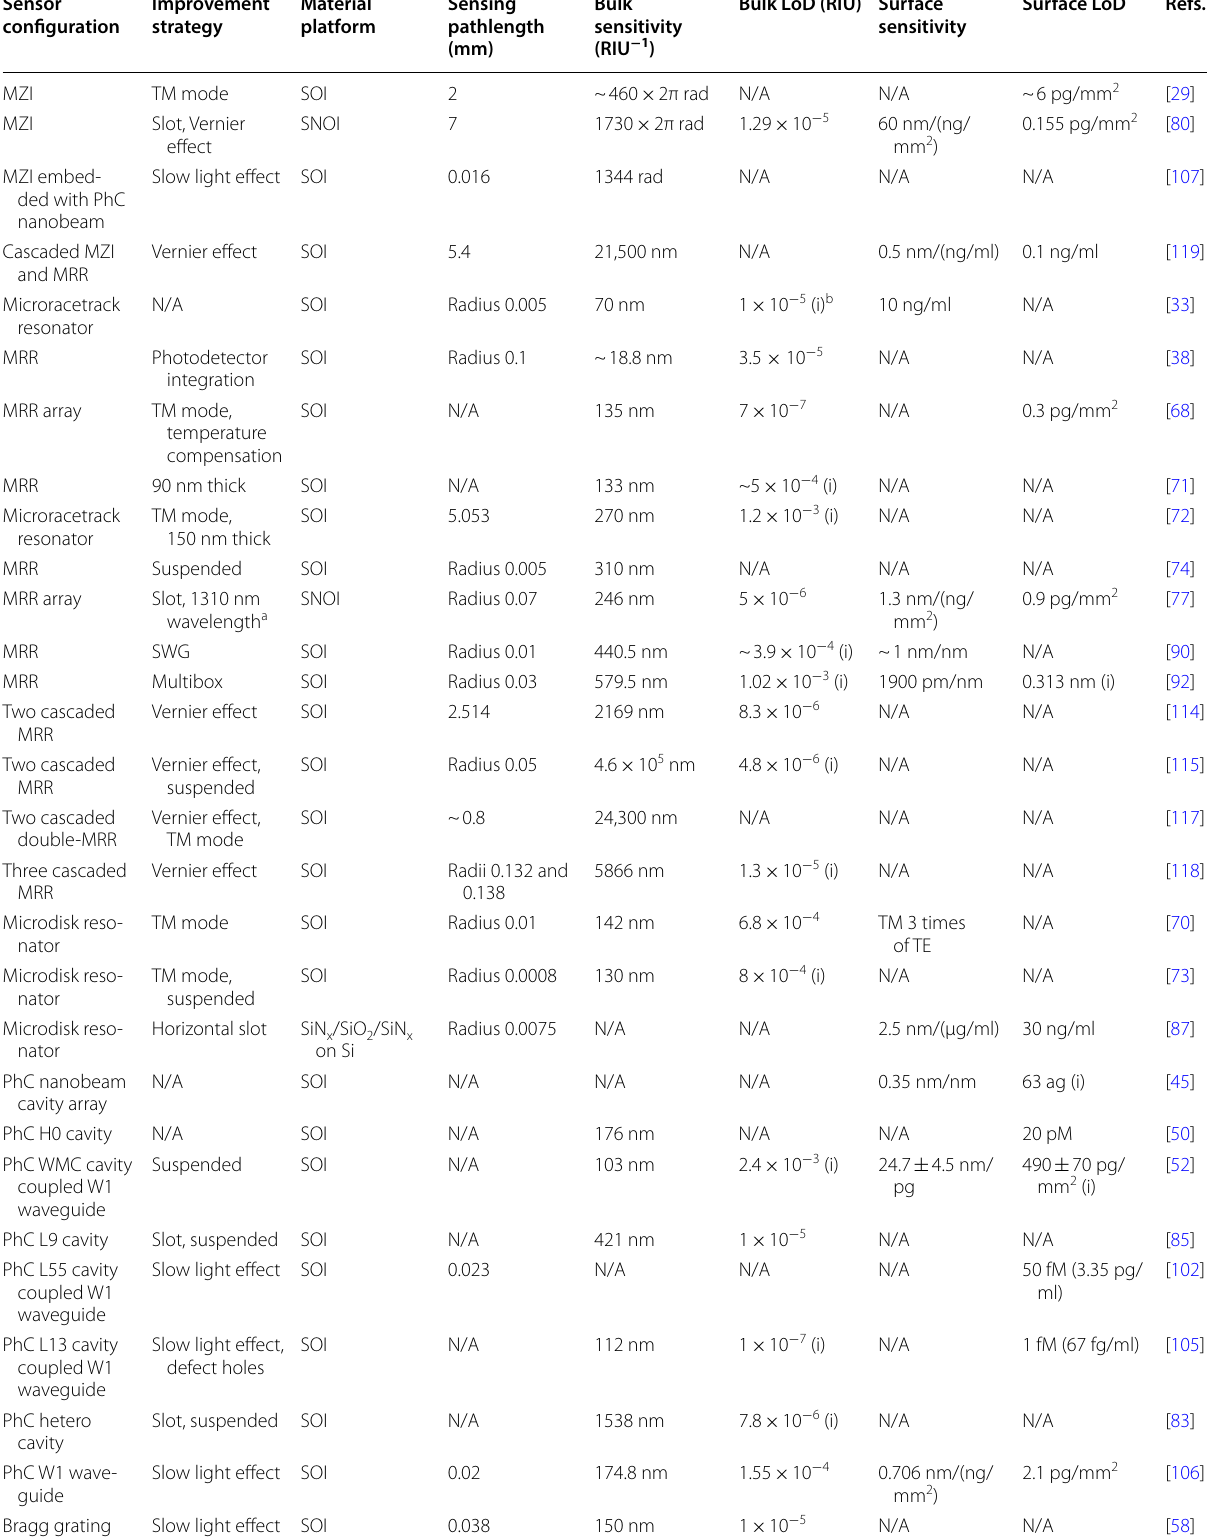
Table 1 Summary of representative RI‑based infrared guided‑wave nanophotonic biochemical sensors Sensor